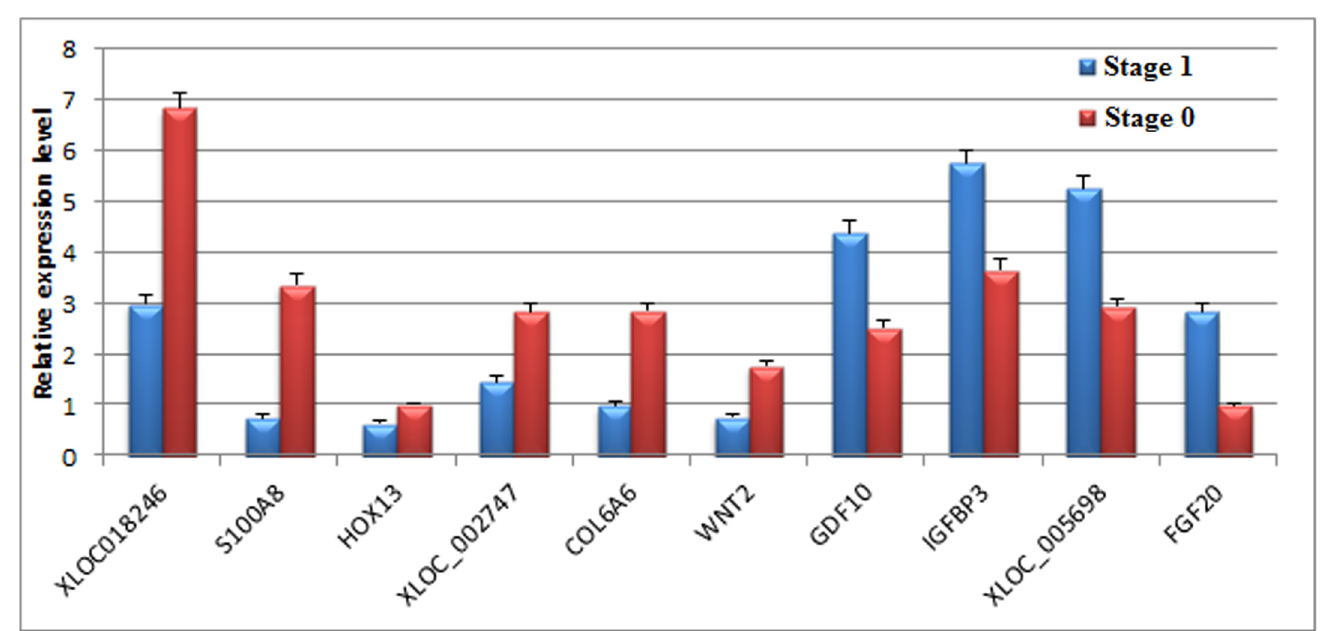
Fig 7. The expression level of differently expressed genes and LncRNAs validated by strand-specific qPCR.